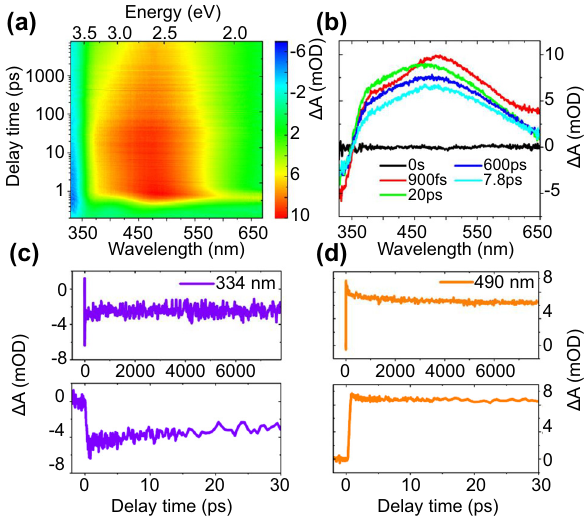
Figure 3: Transient absorption spectra and carrier dynamics at 330 – 670 nm. (a) TA spectrum of MXene film on quartz in the visible probe band (330 – 670 nm) by 1600 nm excitation. The excitation intensity is 0.5 μ J/pulse. (b) TA spectrum at selective pump-probe delay times, showing a TA maximum at 490 nm. (c) Dynamics at 334 nm, giving negative PIB signal. Top panel is the result for the full range (0 – 7.8 ns), the dynamics at 0 – 30 ps is shown in the bottom panel. (d) Dynamics at 490 nm, giving a positive PIA signal. Top panel is the resultforthefullrange(0 – 7.8ns),thedynamicsat0 – 30psisshown in the bottom